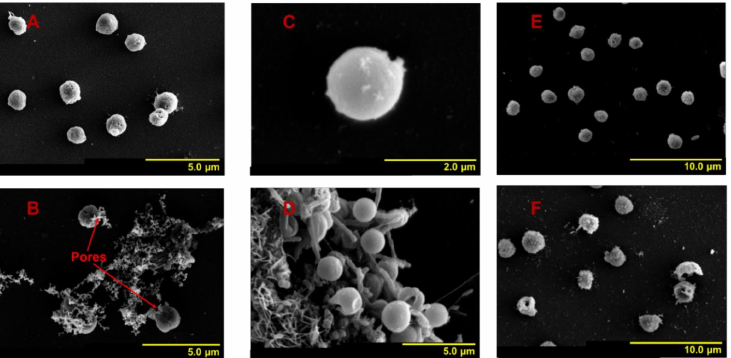
Figure 4. Changes in cell shape features of residual A. anophagefferens (CCMP 1984) after treatment with NC or MC for 72 h and 120 h. ( A , E ) Residual cells treated with NC measured at 72 h and 120 h, respectively (group 2); ( B , F ) residual cells treated with MC measured at 72 h and 120 h, respectively (group 3); ( C , D ) normal cells measured at 120 h (group